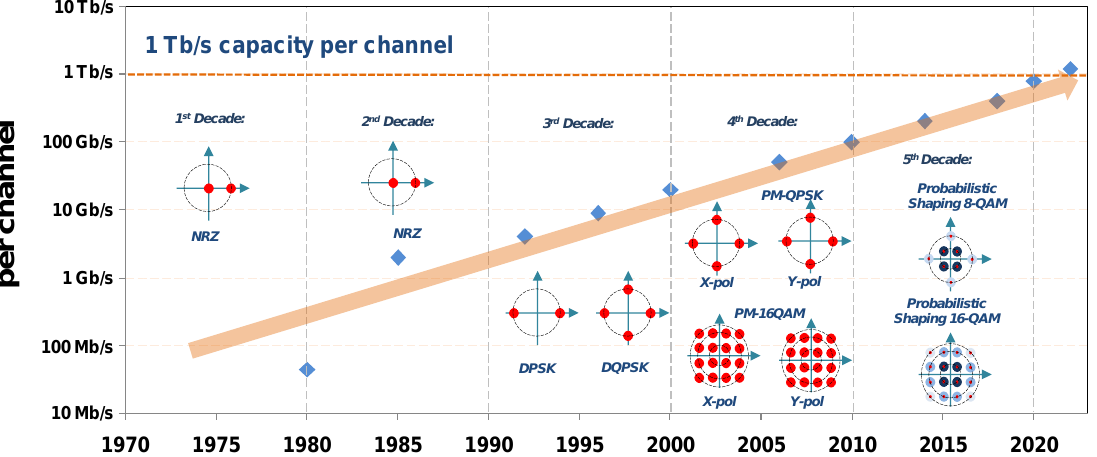
Figure 31. Evolution of transported capacity per single channel for commercially available systems over the last 50 years (based on [82 – 86]).